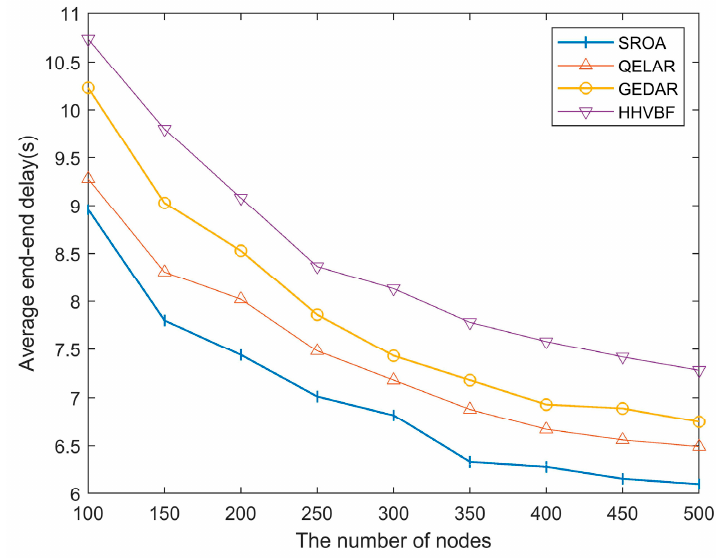
Figure 10. Comparison of average end-to-end delay for the four protocols.